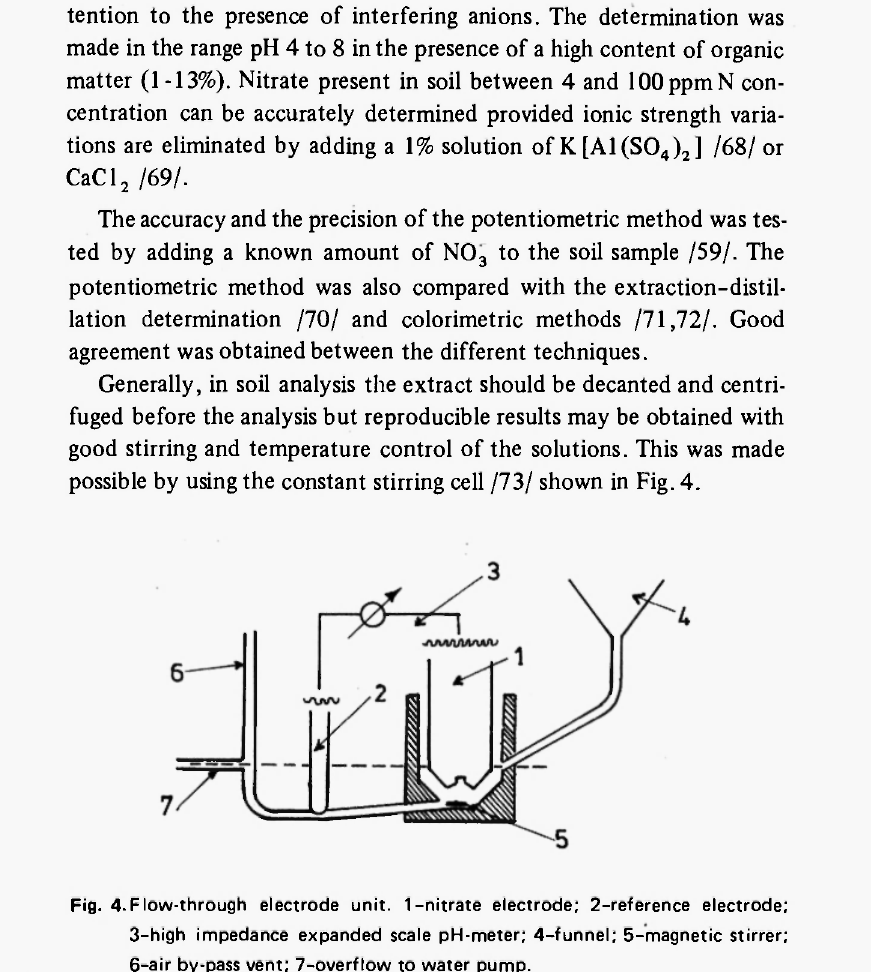
Fig. 4. Flow-through electrode unit. 1 -nitrate electrode; 2-reference electrode; 3-high impedance expanded scale pH-meter; 4-funnel; 5-magnetic stirrer; 6-air by-pass vent; 7-overflow to water